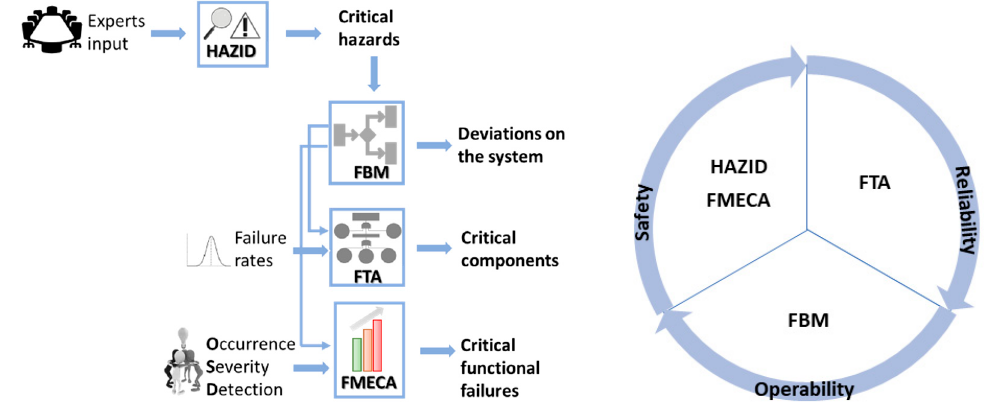
Figure 1. Flowchart the proposed methodology and use of tools for the safety, operability, and reliability analysis.